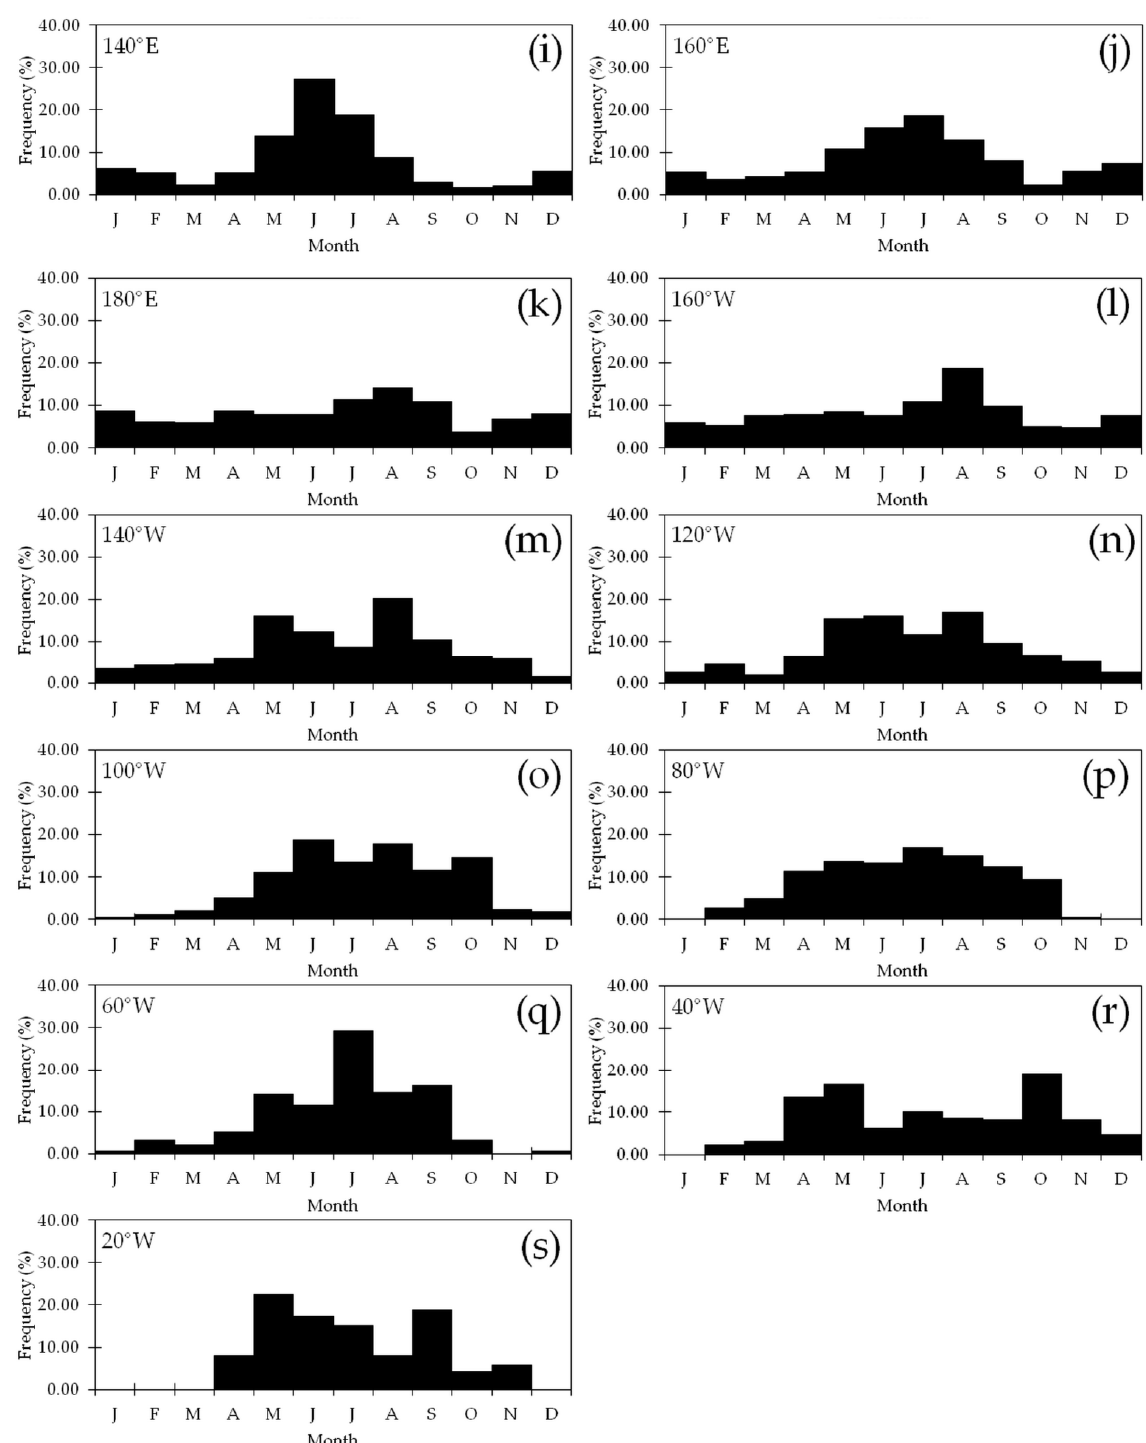
Figure 6. Monthly evolution of the frequency of blocking episodes within the 74-year study period at different longitudes: ( a ) All longitudes; ( b ) 0 ◦ ; ( c ) 20 ◦ E; ( d ) 40 ◦ E; ( e ) 60 ◦ E; ( f ) 80 ◦ E; ( g ) 100 ◦ E; ( h ) 120 ◦ E; ( i ) 140 ◦ E; ( j ) 160 ◦ E; ( k ) 180 ◦ E; ( l ) 160 ◦ W; ( m ) 140 ◦ W; ( n ) 120 ◦ W; ( o ) 100 ◦ W; ( p ) 80 ◦ W; ( q ) 60 ◦ W; ( r ) 40 ◦ W; ( s ) 20 ◦ W. All negative values of the blocking index were included in the calculations regardless of their absolute value. The skewness coefficients of these distributions are: ( a ) 0.54; ( b ) 0.35; ( c ); 1.39 ( d ) 0.96; ( e ) 0.70; ( f ) 0.51; ( g ) 1.53; ( h ) 0.92; ( i ) 1.33; ( j ) 0.77; ( k ) 0.47; ( l ) 1.73; ( m ) 0.88; ( n ) 0.42; ( o ) 0.21; ( p ) ‒ 0.55; ( q ) 0.94; ( r ) 0.53; ( s ) 0.16.